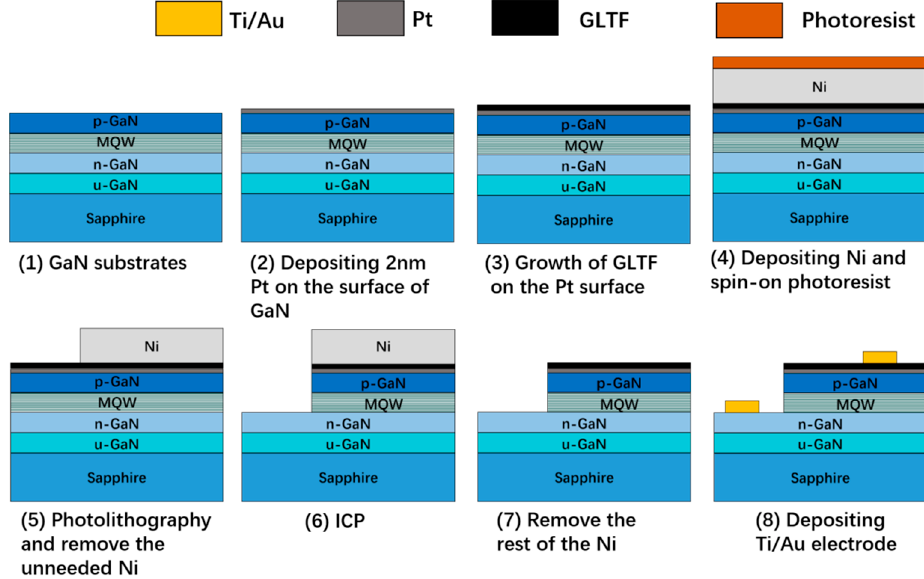
Figure 2. The manufacturing schematic of the light-emitting diodes (LEDs). A device was accomplished by depositing 120 nm of Ni as a dry etching mask on a gallium nitride (GaN) sample pre-deposited with 2 nm Pt and graphene-like thin film (GLTF). Photolithography was then conducted and the Ni patterned. After etching into the heavily doped n-GaN layer using an inductively coupled plasma (ICP) system, the rest of the Ni was removed. Ti/Au (15 nm/300 nm) p and n metal electrodes were also fabricated together by lift-off lithography and sputtering. MQW represents a multiple quantum well.